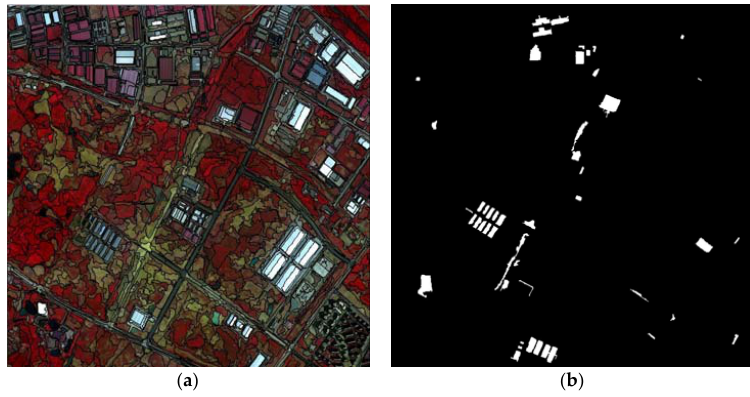
Figure 12. ( a ) The segmentation object map; and ( b ) binary change map after D–S fusion.